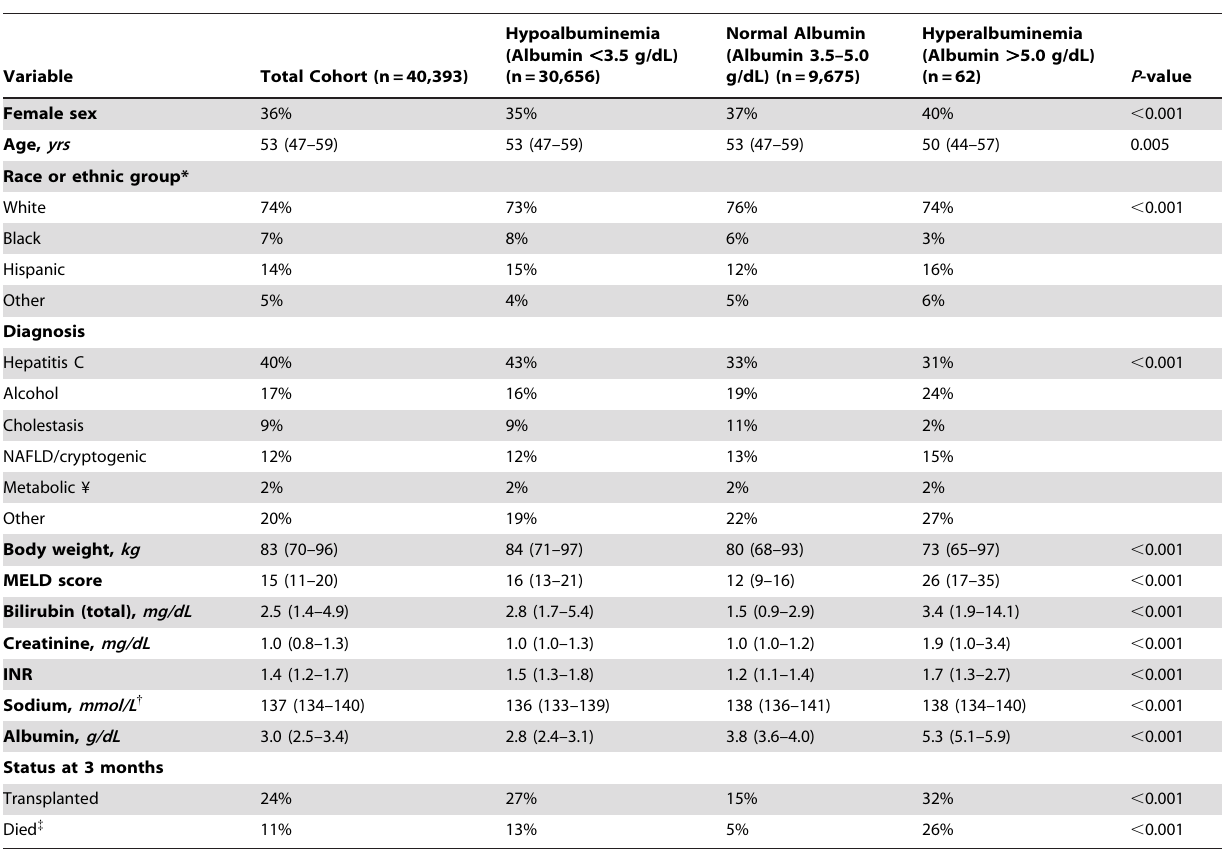
Table 1. Characteristics of Registrants on the Liver Transplant Waiting List.